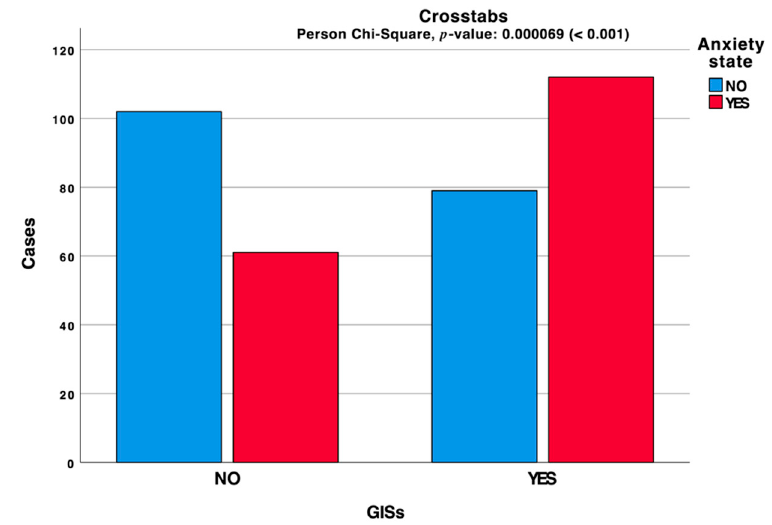
Figure 2. Clustered bar chart based on the contingency table related to the interactions between GISs and anxiety state during the lockdown period. Table 1. Anxiety state: frequency analysis.